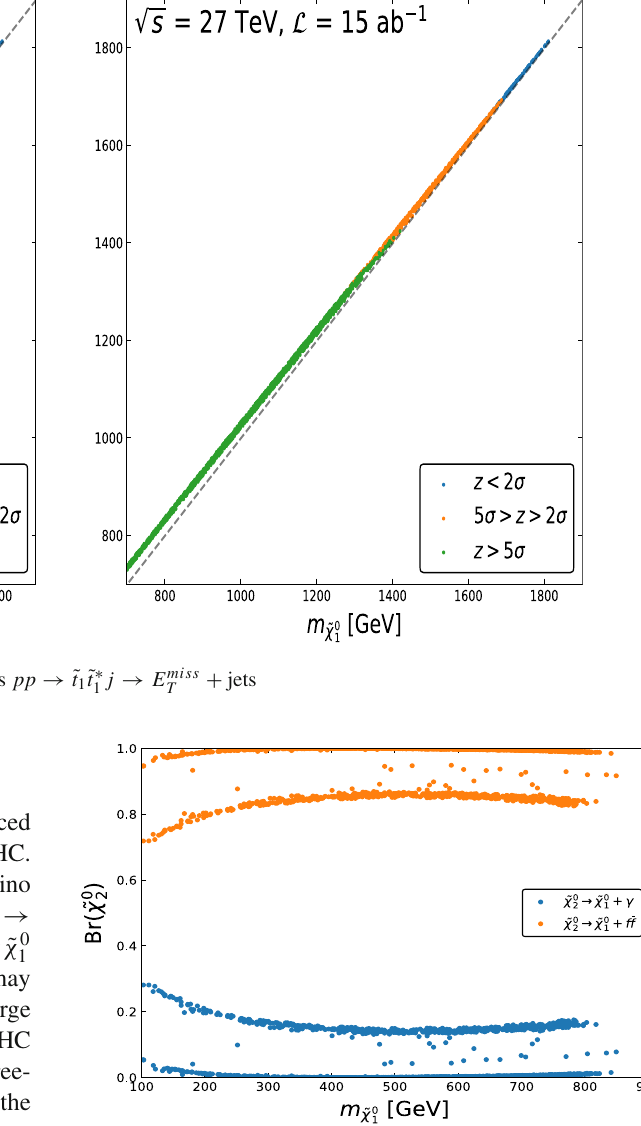
Fig. 10 The branching ratio of ˜ χ ±